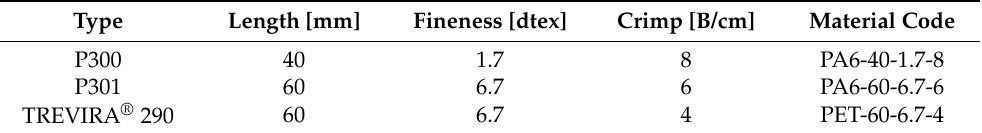
Table 1. Thermoplastic fibers and their textile properties.